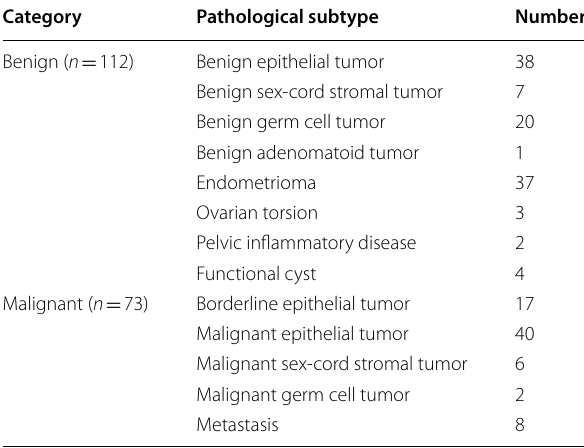
Table 2 Summary of pathological subtypes